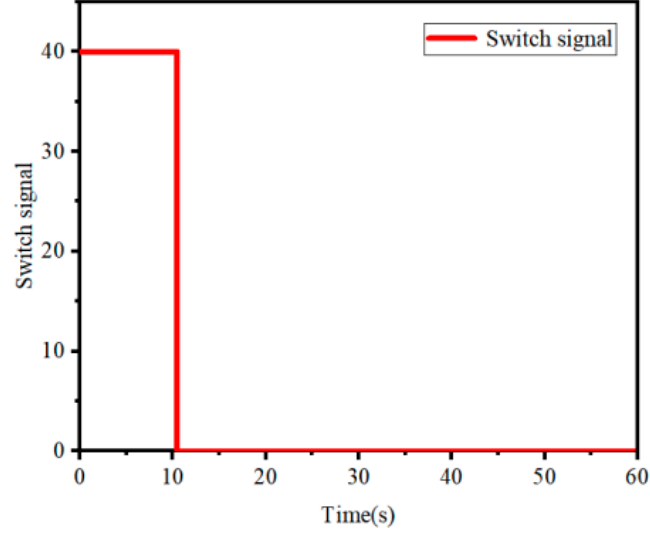
Figure 8. Diagram of the switch signal.